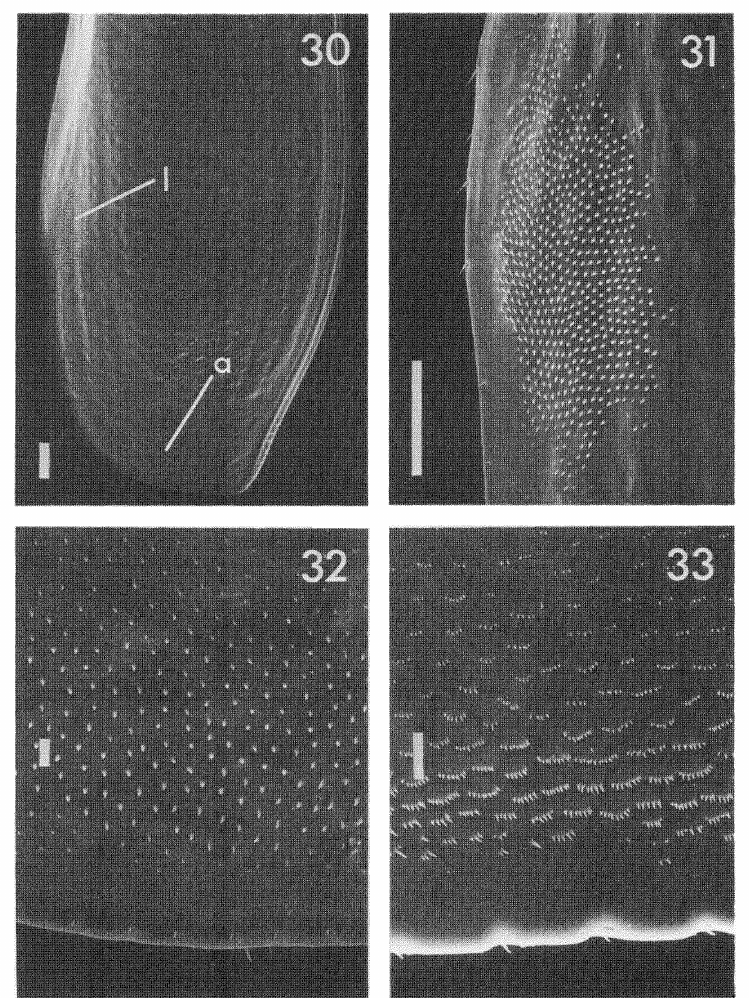
Figs. 30-33. Glypholoma spp., internal elytral surface. 30-32. G. pustuliferum; 30, overall view; 31, detail of lateral area ("1" in fig. 30); 32, detail of apex ("a" in fig. 30). 33. G. rotundulum, same view as fig. 32. Scale lines: figs. 30, 31 0.1 mm; figs. 32, 33 0.01